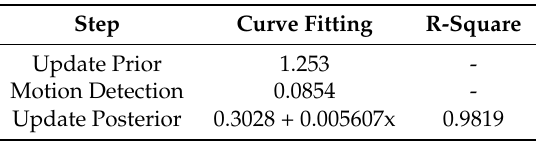
Table 8. GPGPU version, latency per block (ms).